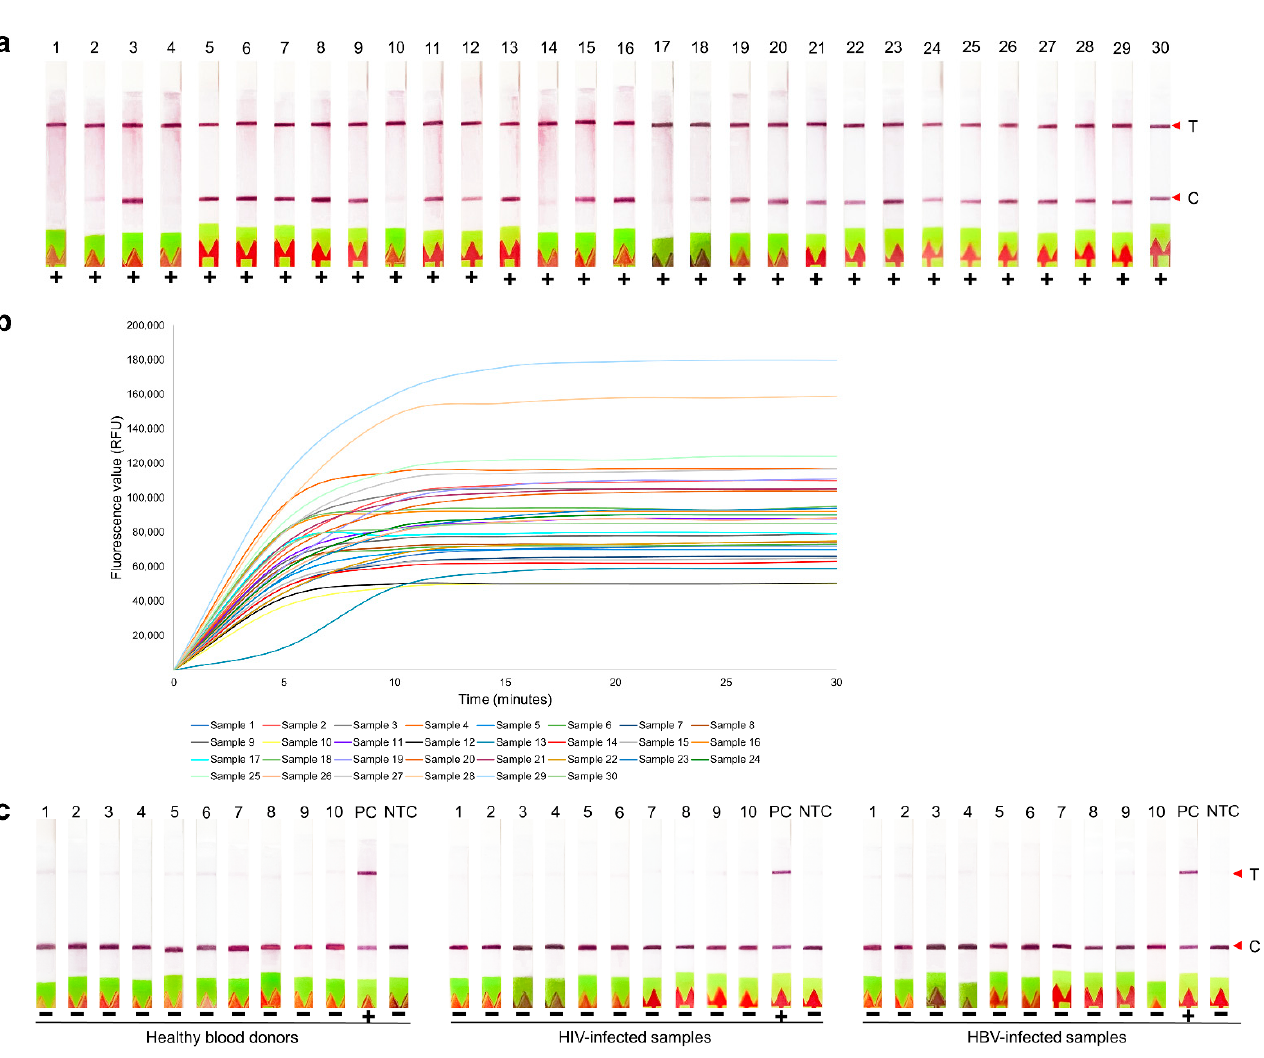
Figure 4. Evaluation of the developed RT-LAMP-coupled CRISPR–Cas12 assay. ( a ) RT-LAMP-coupled CRISPR–Cas12 assay for HCV RNA detection using lateral flow-based readout and ( b ) fluorescence-based readout among the first 30 representative clinical samples from HCV patients while the rest showed similar patterns; ( c ) RT-LAMP-coupled CRISPR–Cas12 assay for HCV RNA detection using lateral flow-based readout among 10 healthy blood donors, 10 HIV- and 10 HBV-infected samples. T, Test line; C, Control line; PC, positive control; NTC, no template control. Table 1. Clinical performance of the RT-LAMP-coupled CRISPR–Cas12 assay. Table 2. Evaluation of the RT-LAMP-coupled CRISPR–Cas12 assay according to HCV genotypes and viral